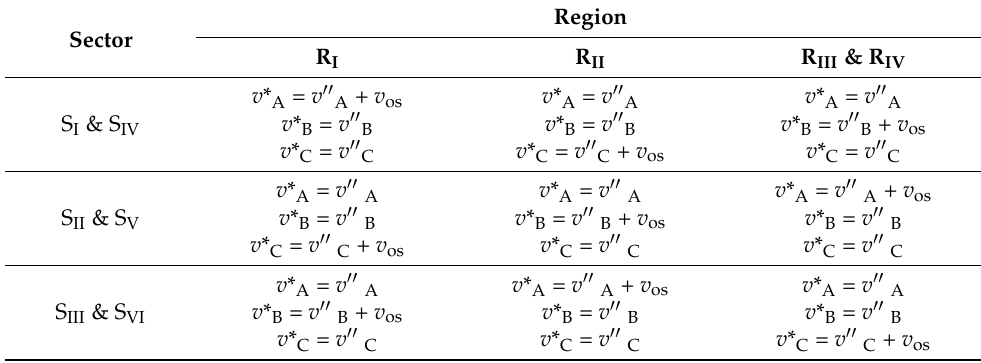
Table 5. Compensation voltage injection rules.